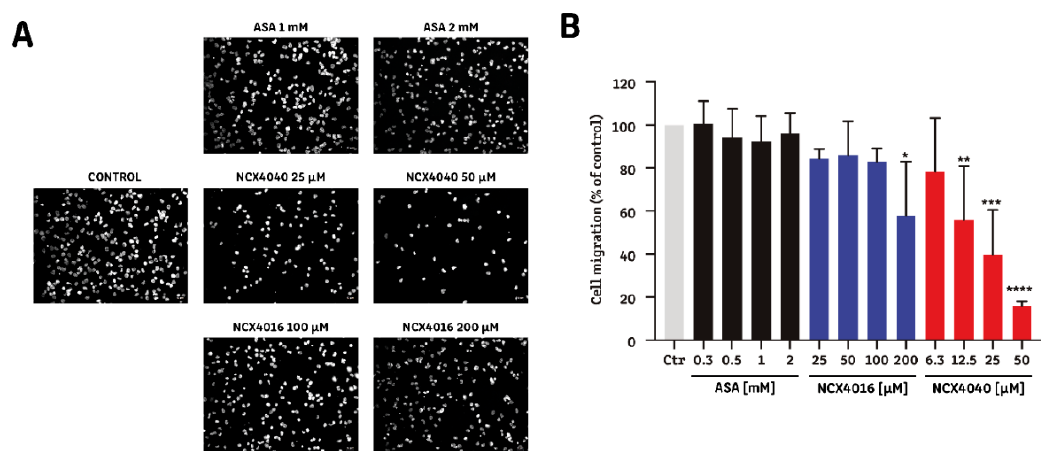
Figure 2. Effect of NO-aspirins on non-small-cell lung cancer cell migration. Assays were conducted by evaluating the migration of H1299 cells through an 8 µM-pore cell culture insert. Cells were stained with DAPI after 6 h of migration. ( A ) Representative images of migration of H1299 cells exposed to aspirin (ASA; 1 and 2 mM), NCX4016 (100 and 200 µM), and NCX4040 (25 and 50 µM). ( B ) Quantitation of migration of H1299 cells exposed to aspirin (ASA; from 0.3 to 2 mM), NCX4016 (from 25 to 200 µM), and NCX4040 (from 6.3 to 50 µM). The bar graph summarizes the results from four independent experiments. * p < 0.05; ** p < 0.01; *** p < 0.001, and **** p < 0.0001, compared with the control group, calculated by one-way ANOVA and Dunnett’s post-test.